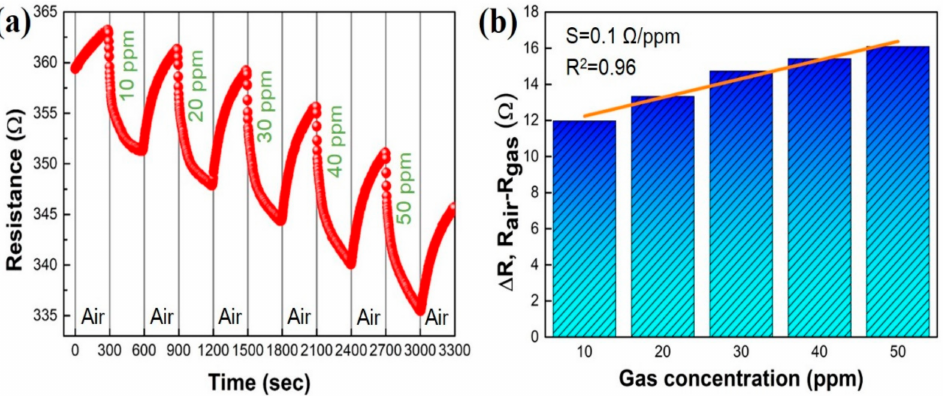
Figure 5. NO 2 gas-sensing performance of GNWs/NiO-WO 3 /GNWs heterostructure-based gas sensor. ( a ) Resistance response depending on NO 2 concentration. ( b ) Sensitivity and coefficient of determination (R 2 ) by ∆ R-versus-gas